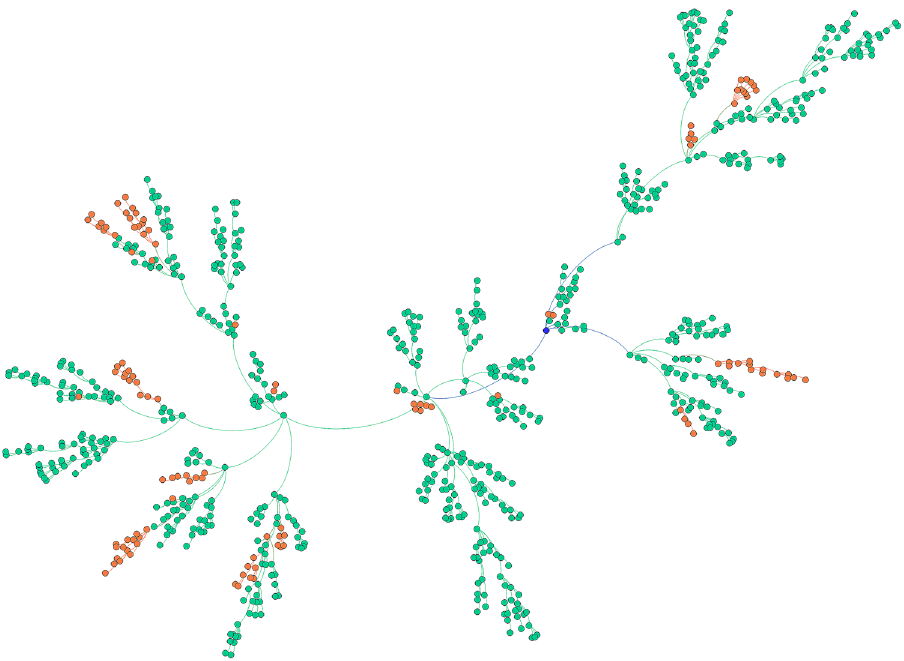
Figure 1. Transmission chain of 802 infectors caused by one infection source. The green circles represent the infectors in Hubei; the red circles represent the infectors in other provinces throughout China; the blue circle represents the first infectious source in the transmission chain; the connection lines represent the transmission